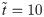
Numerical vs analytical solutions.Comparison between numerical solution obtained by integrating Eq (18) (dots) and (semi-)analytical solution provided by Eq (20) (solid red line) at time t˜=10.